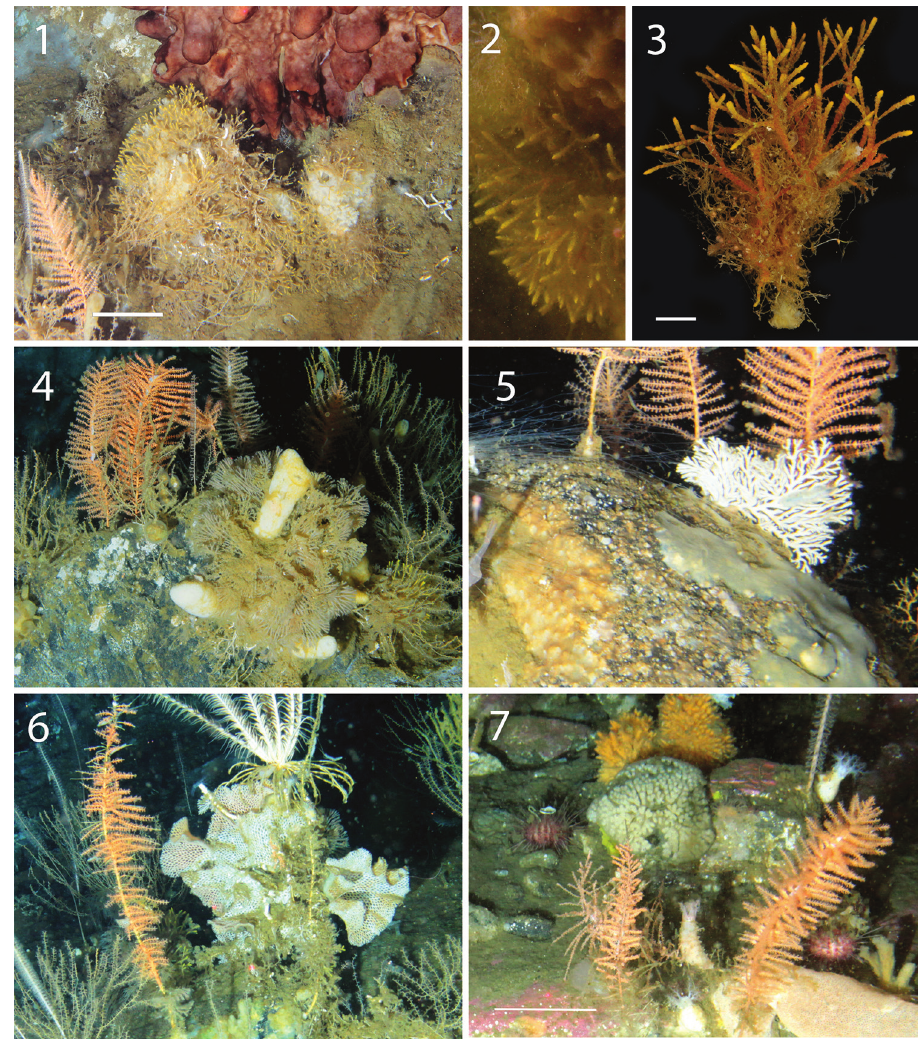
Figure 7. Images of bryozoan colonies in the field obtained through ROV video transect and SCUBA diving. Bushy-colony of Klugella buski Hastings, 1943 (NR) living in association with other bryozoans, hydroids and sponge ( 1 ), a detail of the yellow tips of the colony in the field ( 2 ), and the whole fresh colony after the collection ( 3 ); the last two corresponding to the same voucher (MNA 2872) collected by SCUBA diving; colony of the cyclostome Hornera enclosing a sponge ( 4 ); fan-shaped colony of the cyclos- tome Hornera sp. growing on a boulder ( 5 ); colony of the cheilostome Reteporella sp. living in association with other bryozoans, hydroids, polychaetes ( 6 ); rounded greyish colony of the cyclostome Fasciculipora ramosa D’Orbigny 1839 growing on the sea bottom ( 7